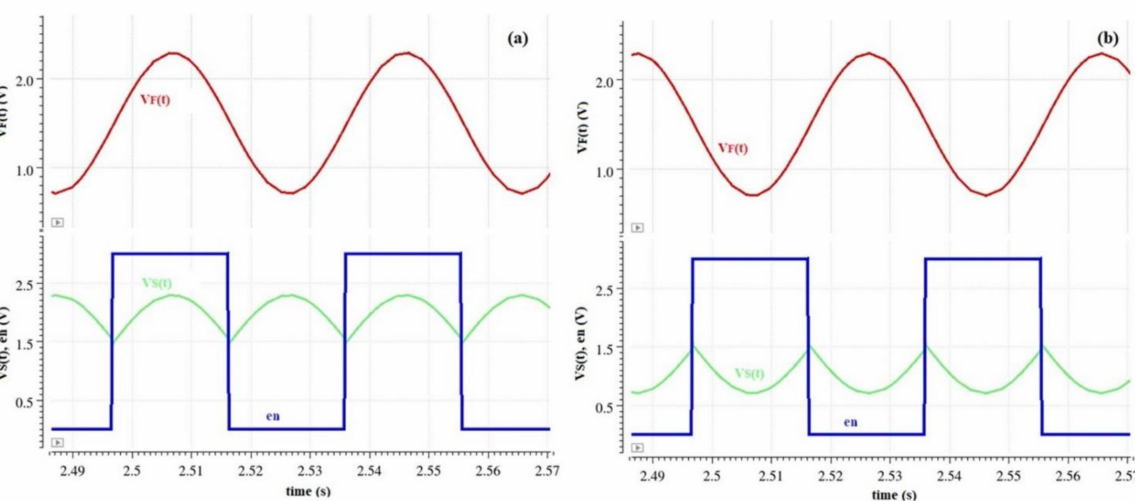
Figure 14. Phase-sensitive detection simulation signals for ( a ) positive and ( b ) negative electric field.